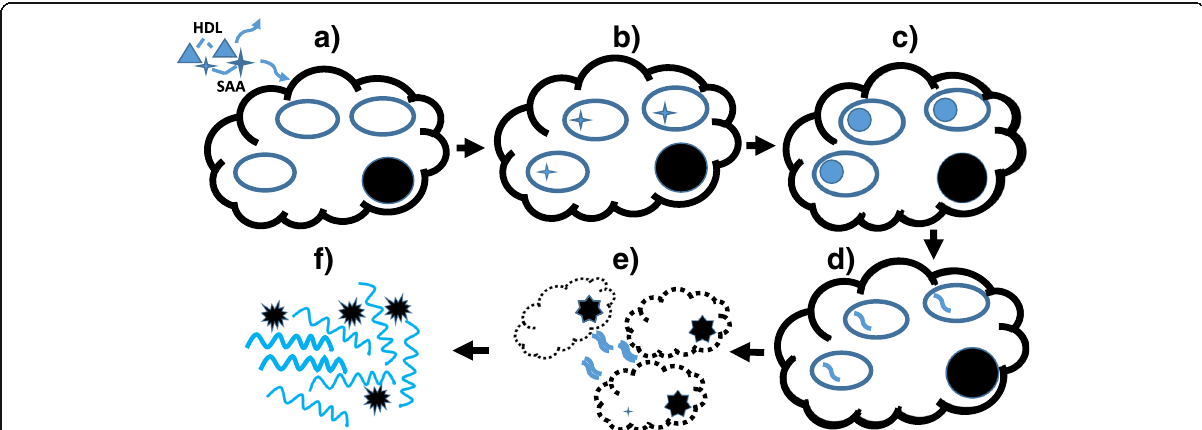
Fig. 4 Proposed scheme for SAA fibril formation. a HDL-bound SAA dissociates from HDL. b {S}AA enters cell via clathrin-coated pits to reside in low pH lysosomal environment. c {S}AA monomers undergo structural rearrangement(s) within lysosome. d AA oligomers form within cells. e Lysis of lysosomal and cellular membranes leads to extracellular oligomers and debris from necrotic cells. f AA oligomers extend into fibrils based on β -pleated sheet domain interactions and become visible as tissue “ amyloid ” deposits with congo red binding. (modified after Claus et al. (2017), Copyright John Wiley and Sons, 2017, used by permission). As described in the text, cleavage of SAA occurs during this process, generally yielding a 76 aa N-terminal fragment. Cleavage may involve a serine protease on the cell surface (Lavie et al. 1978) but the precise site at which this occurs remains unestablished and the undefined nature of the intracellular species in the early stages ( a-c ) is indicated by {S}AA. By stage ( d ) the AA (post-cleavage) species likely